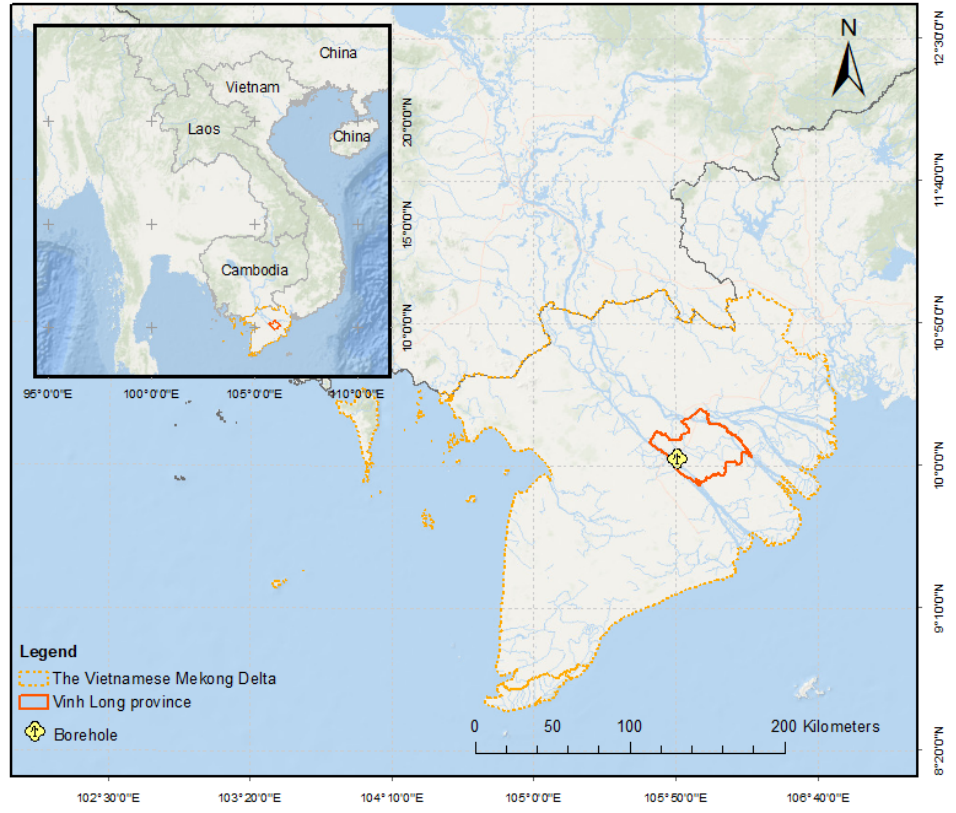
Figure 1. The location of borehole for groundwater extraction.